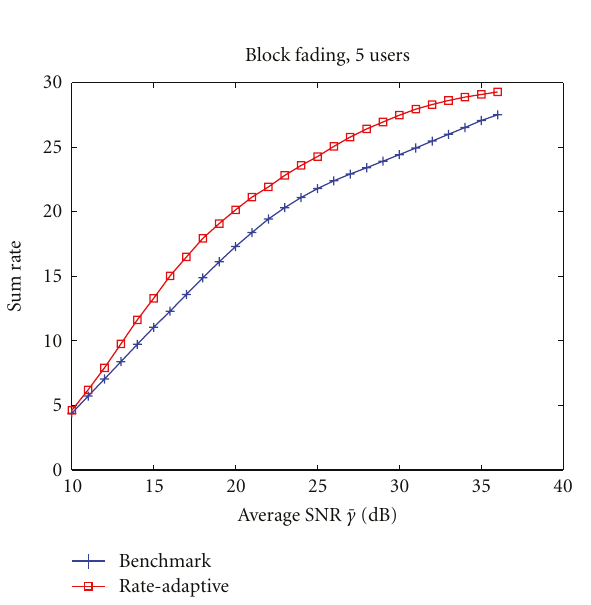
Figure 10: Sum rate for AIR and CIR systems for a Network Coding group with M = 5 nodes. Variable rate nonbinary LDPC codes with 64 QAM modulation have been used. The high values of the rates are due to NC gain. We see how AIR system gains about 2bits/channel use in the higher SNR range. It is interesting to note that almost the same gain has been calculated in Section 5 when considering the average achievable rates for CIR and AIR systems with the same number of nodes at lower SNRs.